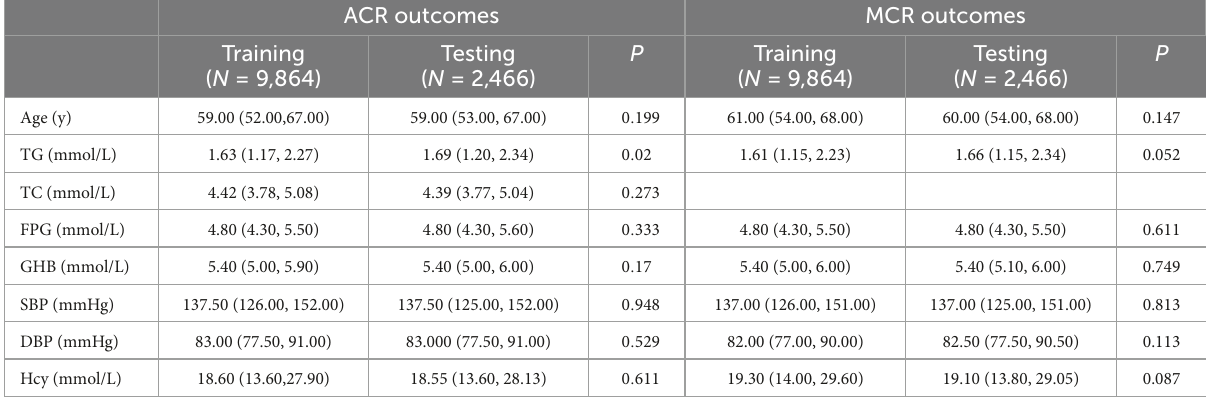
TABLE 2 Comparisons of quantitative clinical indexes between training set and testing set.